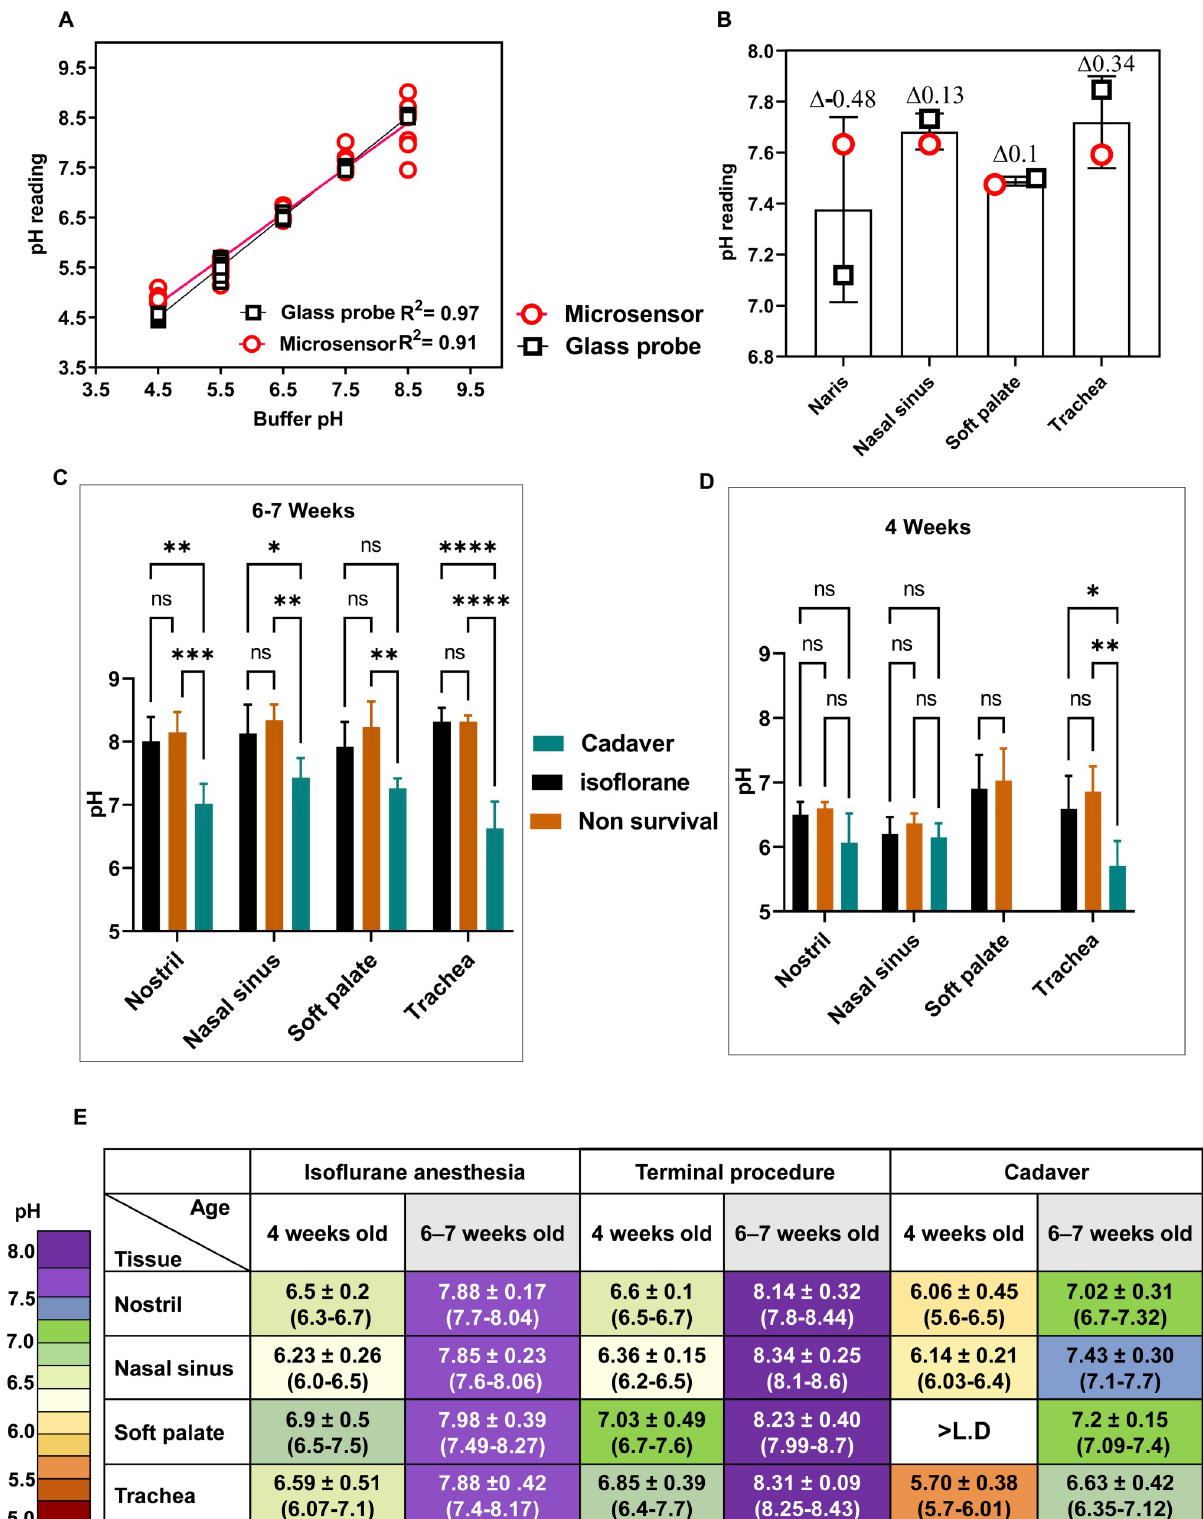
Fig 1. Calibration and optimization of microsensor-measured pH in the respiratory tracts of uninfected DBA/2 mice. (A) Calibration curves of pH-adjusted buffers using both a glass electrode probe (black squares) and a microsensor (red circles). Values were measured at 25˚C with both probes